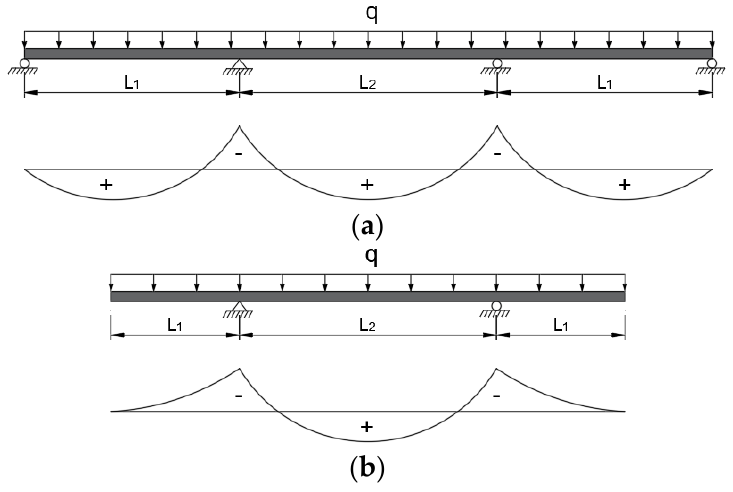
Figure 1. Bending moment diagram. ( a ) Continuous beam, ( b ) Overhanging beam.